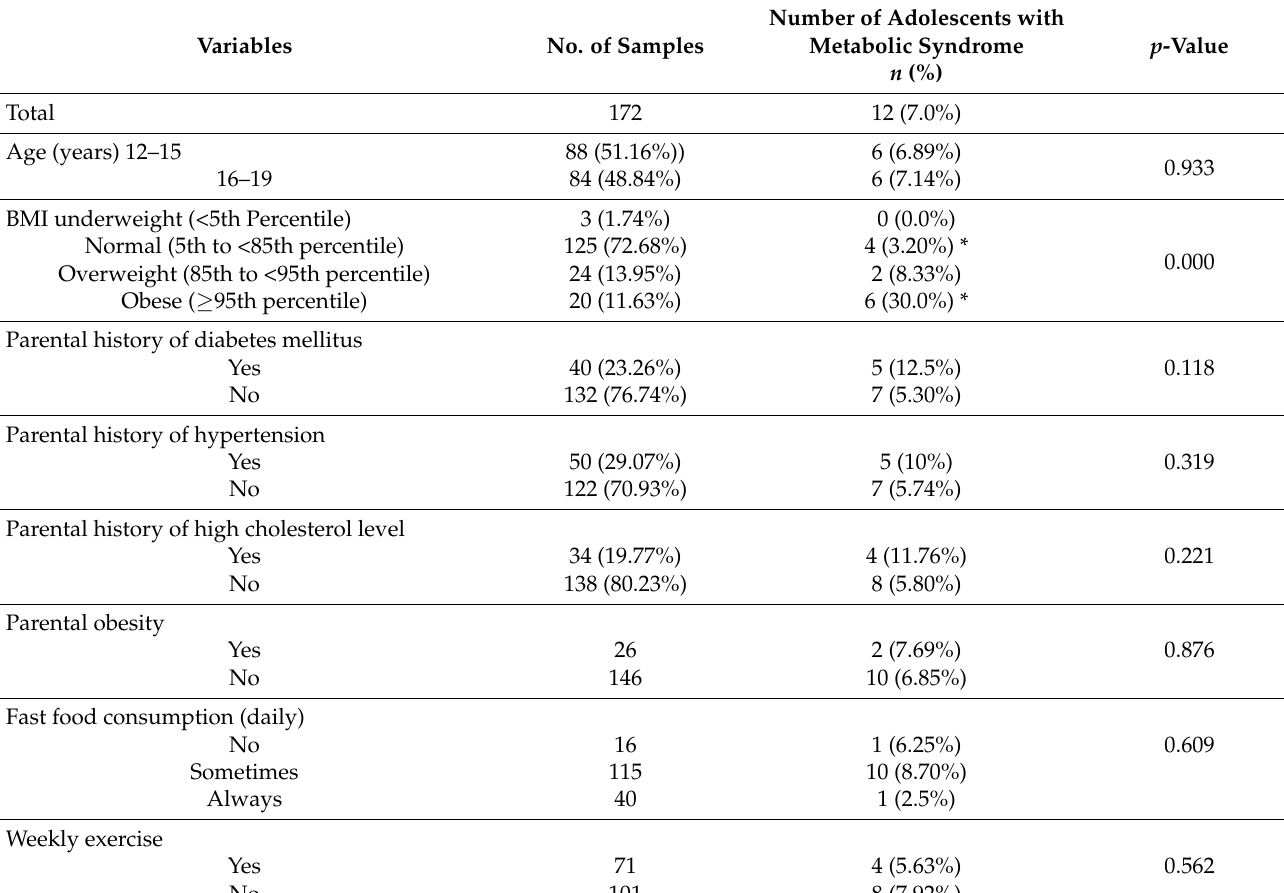
Table 3. Prevalence of Metabolic Syndrome among female Saudi Adolescents aged 12–19 years by demographic and dietary